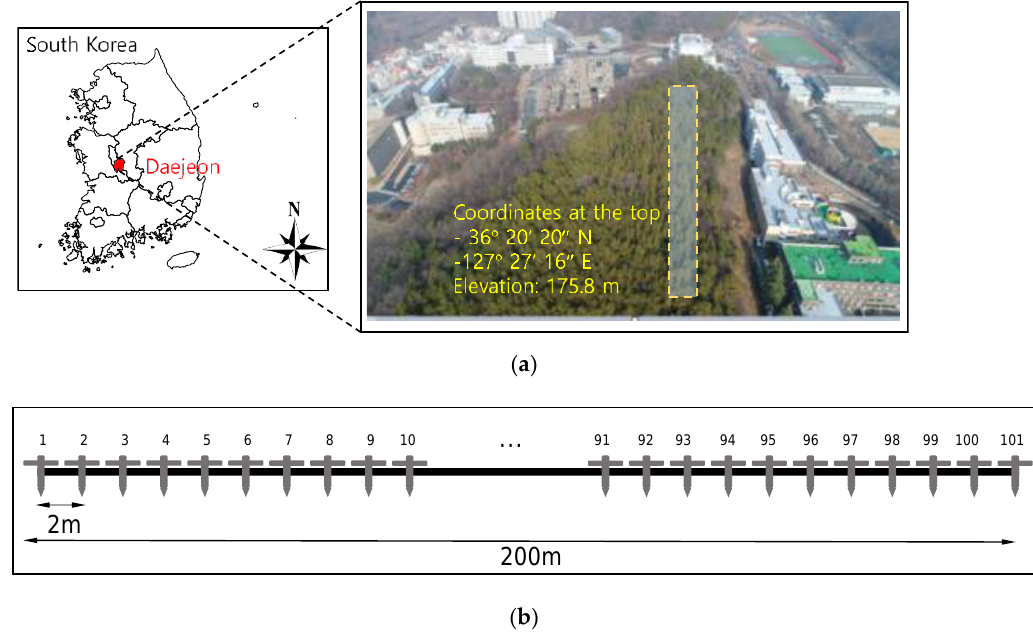
Figure 1. Site description: ( a ) research area; ( b ) electrode installation. The straight line of the electrical resistivity was set to a length of 200 m at the moun- taintop to cover all the reinforced areas. A Wenner array was selected because it is suitable for vertical measurements. The electrodes were installed at equal spacing intervals of 2 m, and a total of 101 electrodes were used. Stainless steel, which experienced a small oxida- tion reaction, was applied as the electrode material for long-term monitoring, and the length and diameter of the electrode were 0.5 and 0.01 m, respectively. Sting R1, pur- chased from AGI, was utilized to obtain the electrical resistivity. Voltage and current val- ues of 10 V and 250 mV, respectively, were applied.